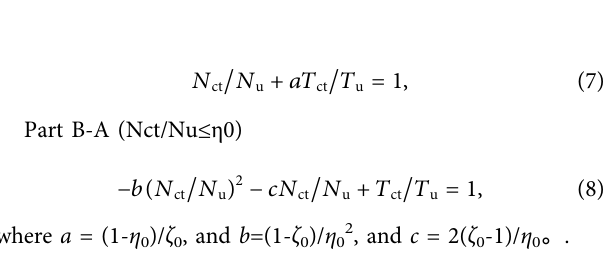
FIGURE 29 | Comparison of T ctc and T ctt of specimens under compressive torsional load.